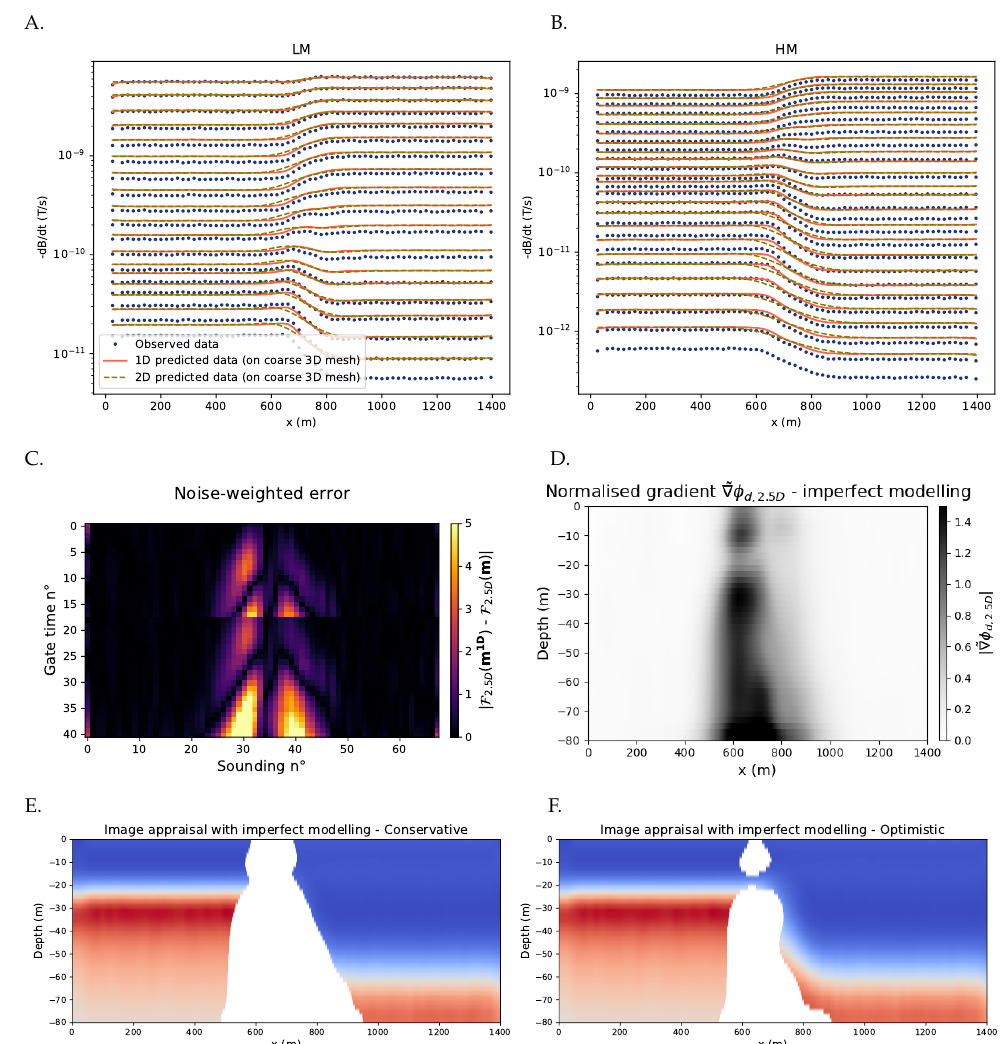
Figure 4. Image appraisal with imperfect forward modeling approach. ( A , B ) A discrepancy mainly near the x = 700 m interface. ( C ) The individual noise-weighted errors. The first 18 gate times correspond to the LM and the 23 last gate times to the HM. ( D ) The normalized gradient indicates areas near the x = 700 m interface. ( E , F ) Image appraisal outcomes clearly indicate problematic areas in the region near the ‘step’.